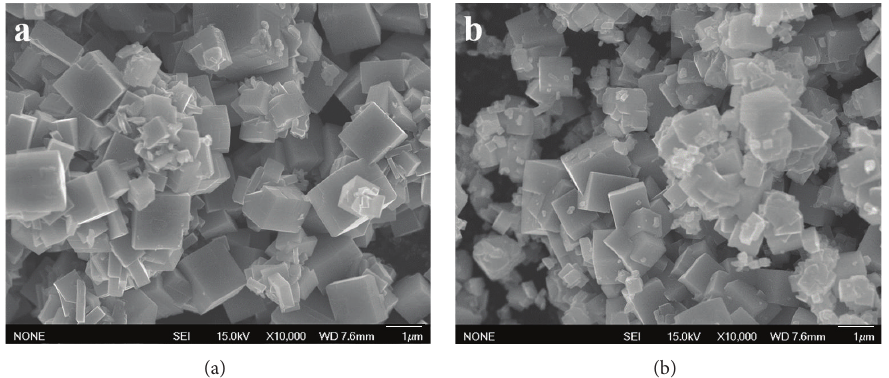
Figure 2: SEM images of the as-prepared (a) NaNbO 3 and (b) La, Co codoped NaNbO 3